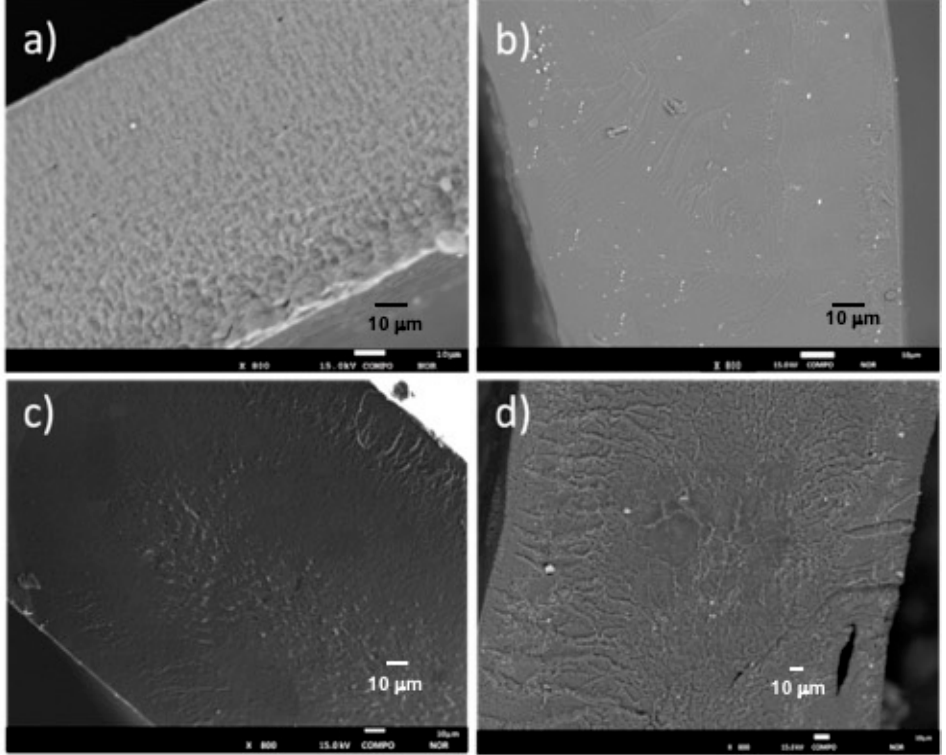
Figure 2. Cross-sectional SEM + BSE images of the GPEs based on: ( a ) PAN; ( b ) PAN/org-SWy; ( c ) PAN:PEO; and ( d ) PAN:PEO/org-SWy.